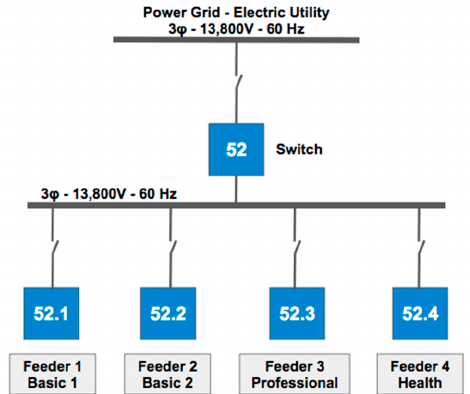
Figure 6. UFPA Belém Campus Electric System Simplified Diagram [21]. Figure 6. UFPA Bel é m Campus Electric System Simplified Diagram [21].